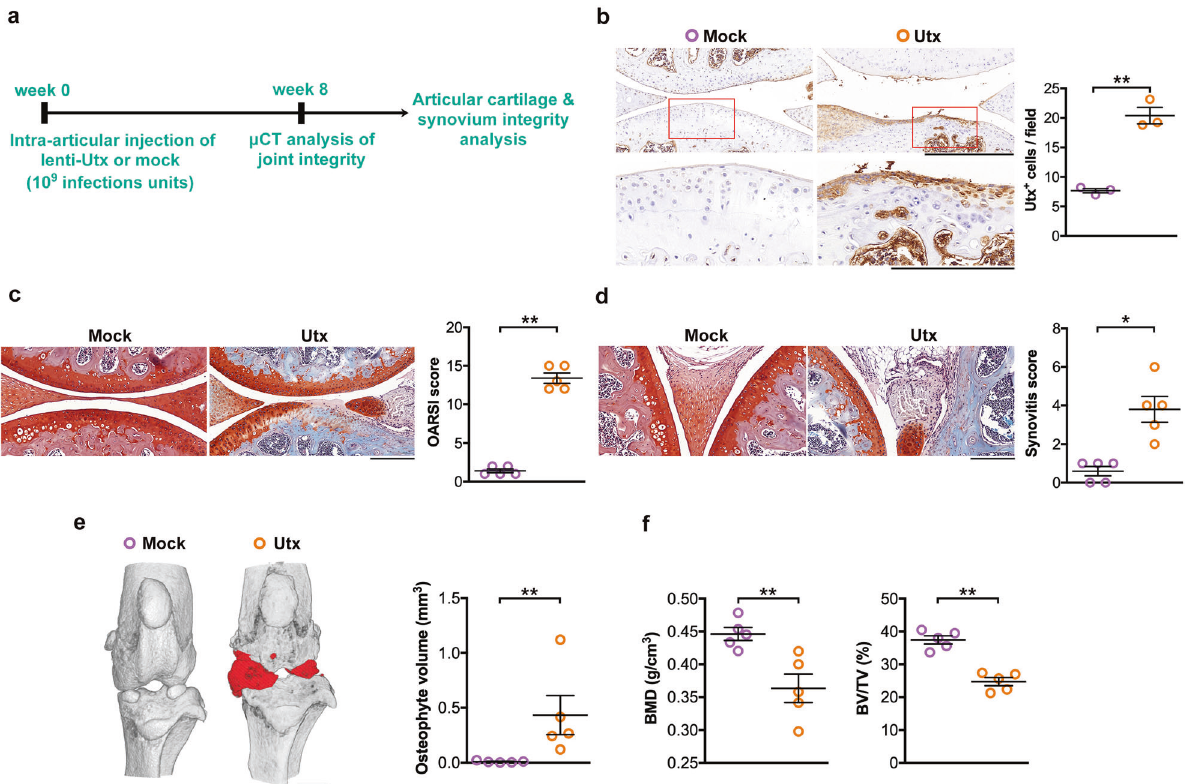
Fig. 2 Signs of OA upon forced expression of Utx in mice. Schematic drawing for intra-articular injection of lentivirus Utx ( a ). Strong Utx immunostaining in articular cartilage upon intra-articular injection with lentiviruses expressing Utx ( b ); scale bar, 20 μ m (low magni fi cation) and 10 μ m (high magni fi cation). Severe cartilage disintegration ( c ; scale bar, 20 μ m) and synovial hyperplasia ( d ; scale bar, 100 μ m) in Utx-treated murine knees, as evident from OARSI and synovitis scoring. Forced Utx expression induced osteophyte formation (red; scale bar, 0.5 mm) ( e ) but reduced BMD and BV/TV ( f ) of subchondral bone. Data are expressed as mean ± standard errors ( n = 5). * P < 0.05; ** P <